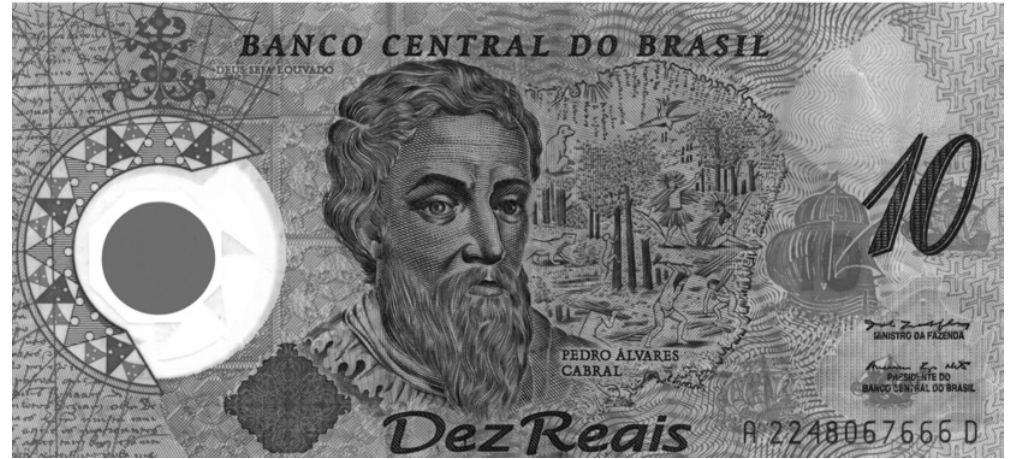
Fig. 2 – One side of the plastic bill of ten reais (Brazilian currency, 2000), part of Carta do Brasil made by Lopo Homem-Reinéis, 1519.